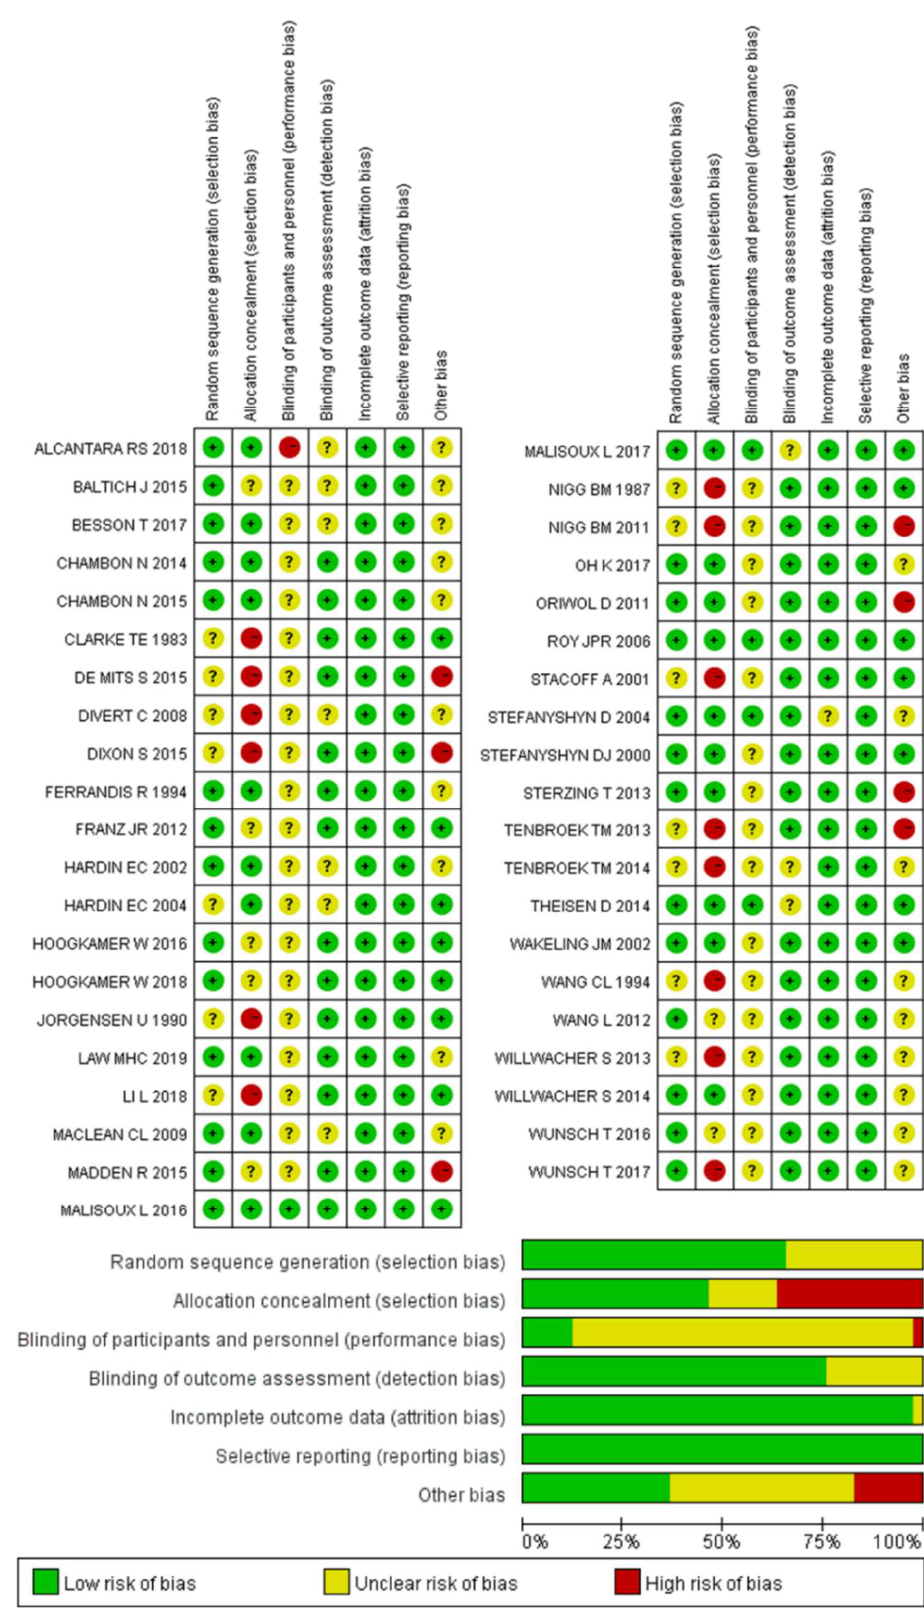
Figure 2. The result of the risk of bias assessment.